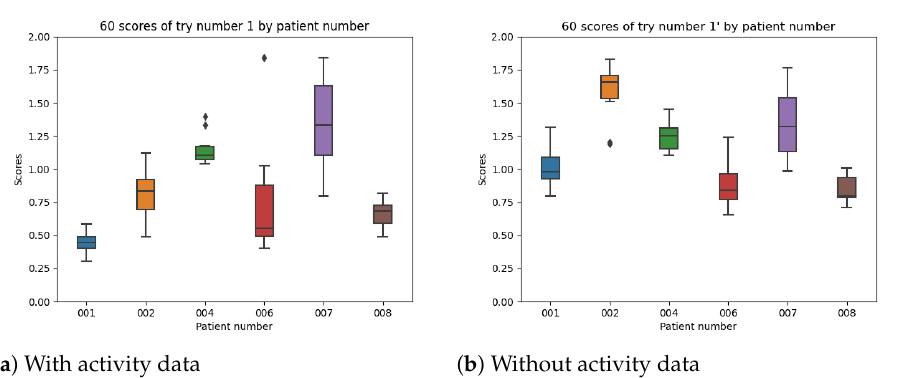
Figure 20. Experiment 1 boxplot with and without activity